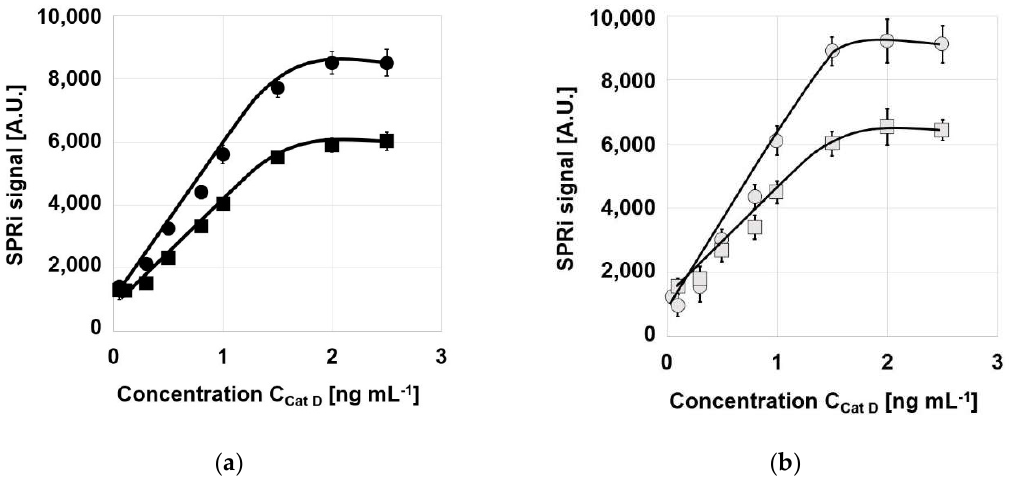
Figure 2. Calibration graphs of Cath D biosensors based on: ( a ) pure gold chips; ( b ) Ag/Au chips, covered with adhesive foil (circles) or two photopaints (squares). Concentration of pepstatin A: 500 ng mL −1 , pH: 3.75.